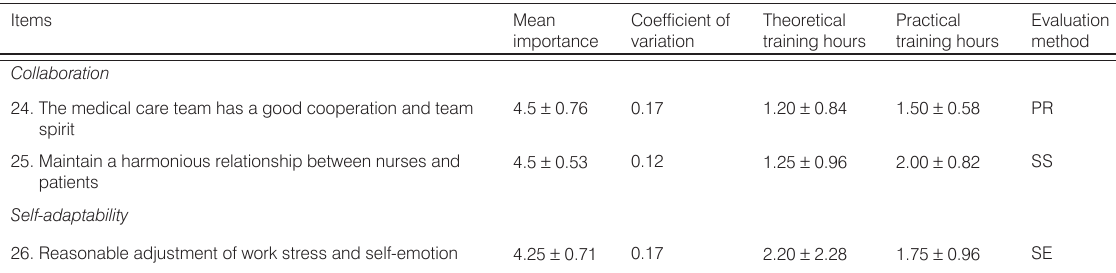
Table 4. Core competencies of backup nurses for interpersonal skills.